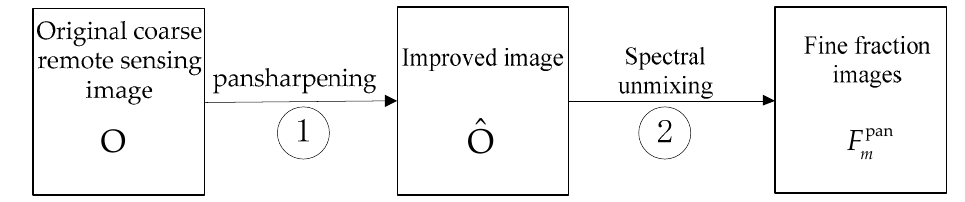
Figure 5. The flowchart of the pansharpening path.